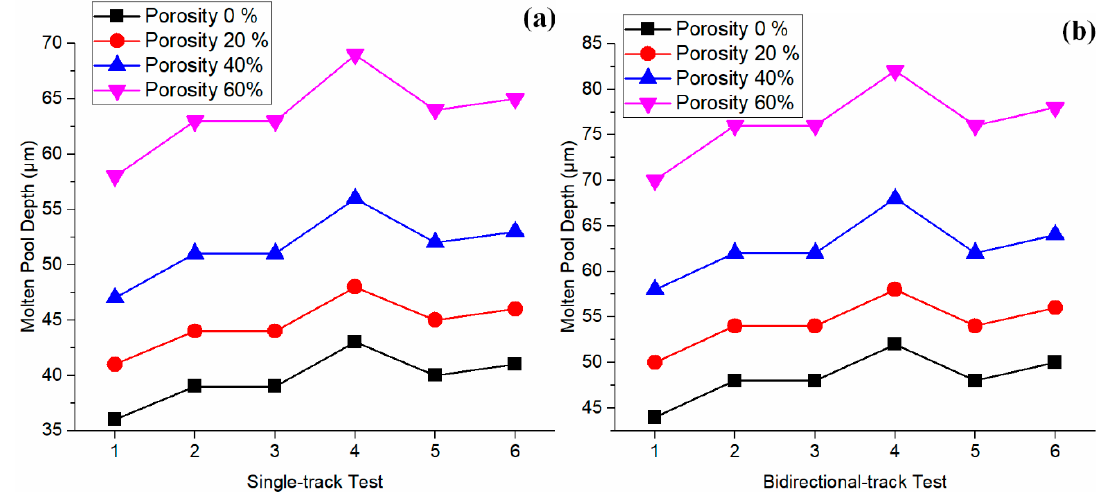
Figure 9. Influence of powder packing porosity on temperature distribution through sensitivity analyses in ( a ) single track scans and ( b ) bidirectional scans. Note: the presented results are obtained from prediction using the simple fraction models with the determined absorption of 40%.